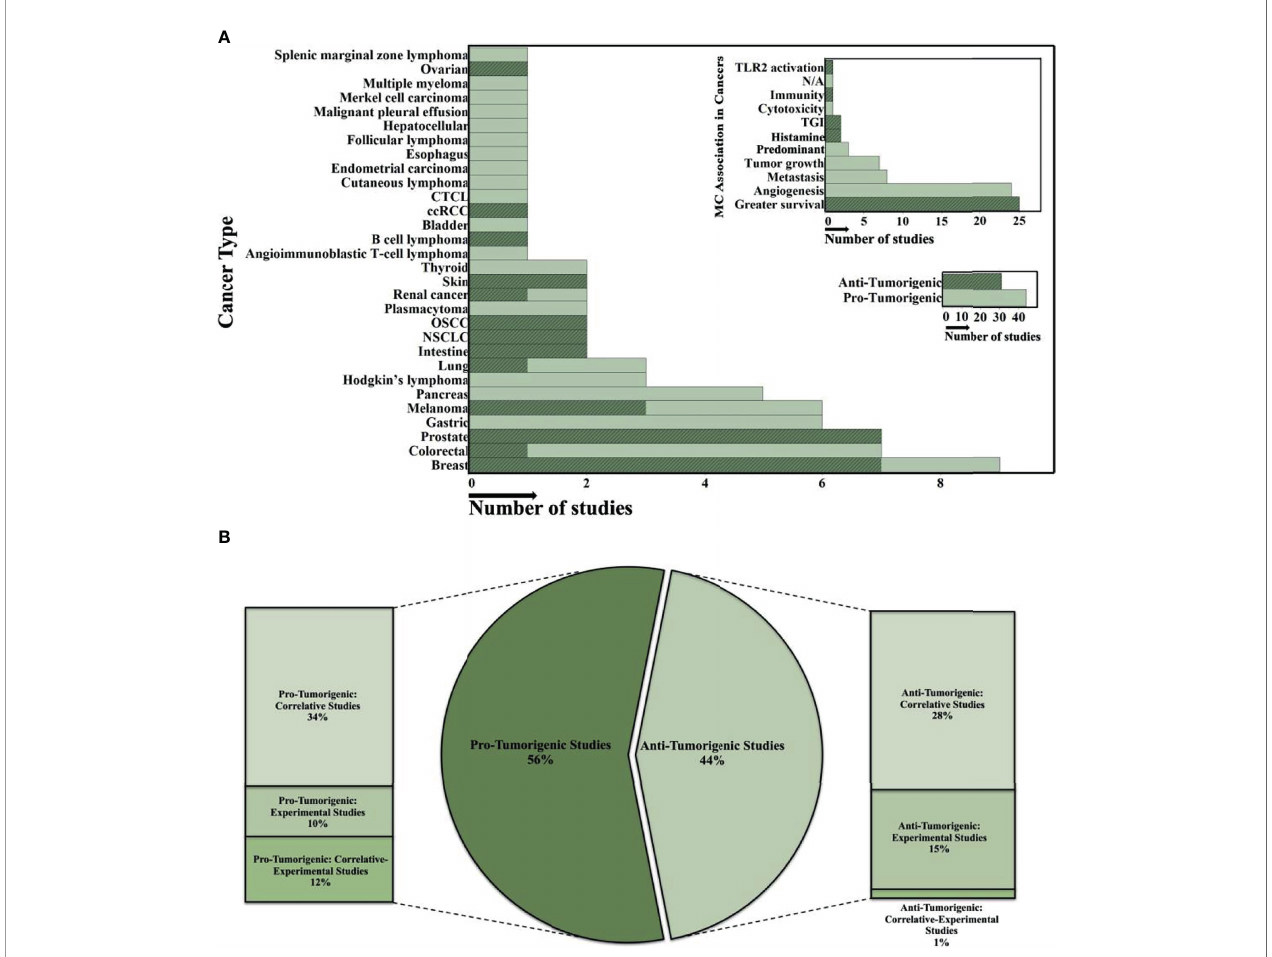
FIGURE 1 | Overview of the role of human MC in different cancerous microenvironments. (A) The histograms summarize the data analysis from 75 published studies on MC's anti- or protumorigenic role in the various human cancer microenvironments. The y-axis shows cancer types and MC association in different tumor environments in the large and small histogram-top, respectively. The x-axis indicates the number of studies (all histograms). Highlighted regions demonstrate the number of anti-tumorigenic studies. JMP software was used to show the distribution of number of studies and fi nding across the categorical variables such as cancer type and MC association in tumor microenvironments in the 75 published studies. (B) The Bar-Pie chart illustrates the percentage of the 75 published studies which focused on either anti- or protumorigenic effects of MCs in various cancer microenvironments. In all studies, descriptive analysis is the primary evaluation strategy for MCs role in different cancer microenvironments. In the second step, most of the studies investigated either the Correlative, Experimental, or combination (Correlative-Experimental) approaches. Cutaneous T Cell Lymphomas (CTCL); clear-cell Renal Cell Carcinoma (ccRCC); Oral Squamous Cell Carcinoma (OSCC); Non-SmallCell Lung Cancer (NSCLC); Toll-Like Receptor 2 (TLR2); Tumor Growth Inhibitor (TGI). Predominant is predominancy of the numbers of in fi ltrated MCs that was investigated in some studies showing the pro-tumorigenic effect on some cancers at certain